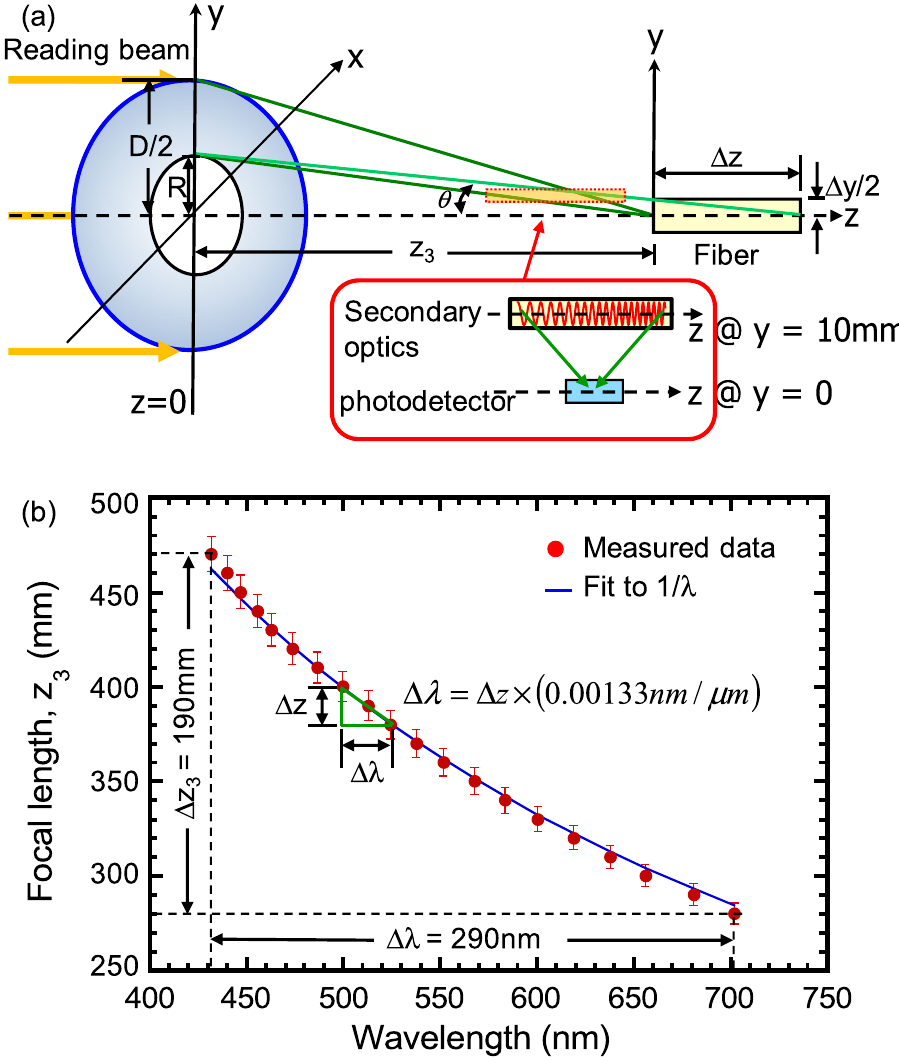
Figure 7. Spectra dispersion and resolution of Fresnel Hologram on the optical axis. ( a ) Reading geometry of the hologram and the image of a monochromatic light λ at its focal length z 3 . The detecting length Δ z and width Δ y are also indicated. ( b ) A summary plot of the measured focal length z 3 versus reading λ . The red dots are experimental data with 2% error bar and the blue curve is a simulated result ( z O = − 25.2 cm, z R = − 72